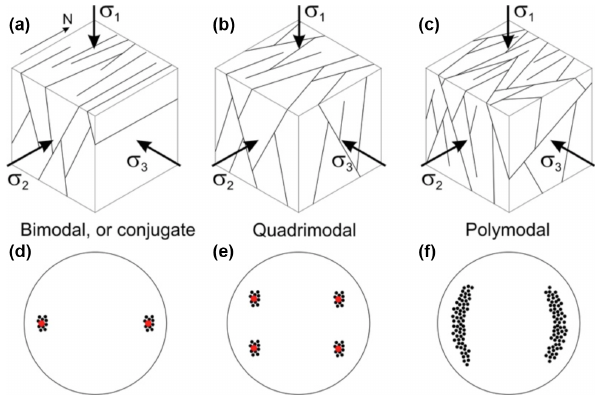
Figure 1. Schematic diagrams to compare conjugate fault patterns displaying bimodal symmetry with quadrimodal and polymodal fault patterns displaying orthorhombic symmetry. (a–c) Block di- agrams showing patterns of normal faults and their relationship to the principal stresses. (d–f) Stereographic projections (equal area, lower hemisphere) showing poles to fault planes for the models shown in (a) – (c) . Natural examples of all three patterns have been found in naturally deformed rocks.